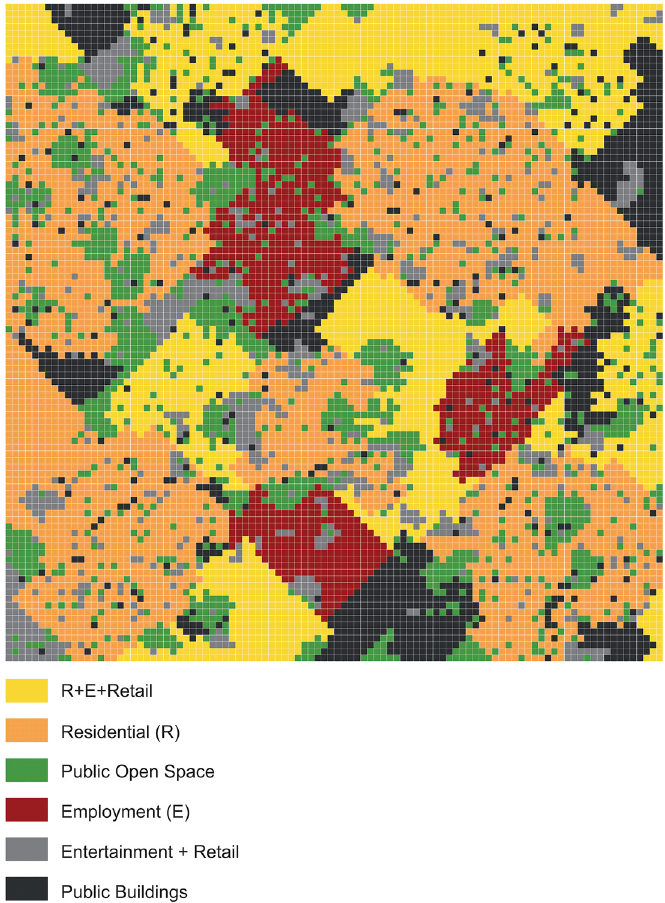
Fig 1. A typical example for land use spatial distribution in the simulated environment.